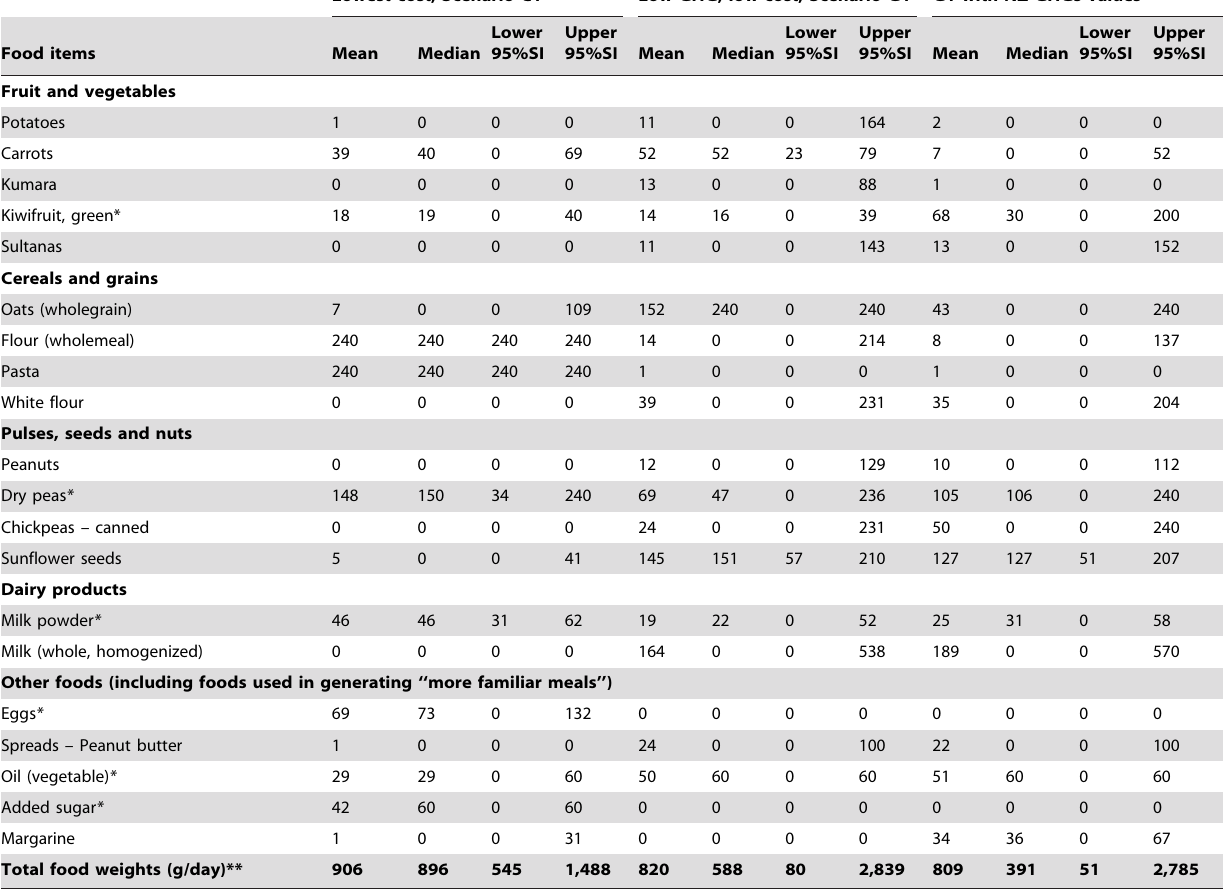
Table 4. Simulation intervals of selected foods (with daily weights of foods in g/day) included in the various daily dietary scenarios for the lowest cost diet (C1); a low-cost and low-GHG emissions diet (G1); and C1 and G1 with NZ GHGs values as a result of the optimization process (n=2000